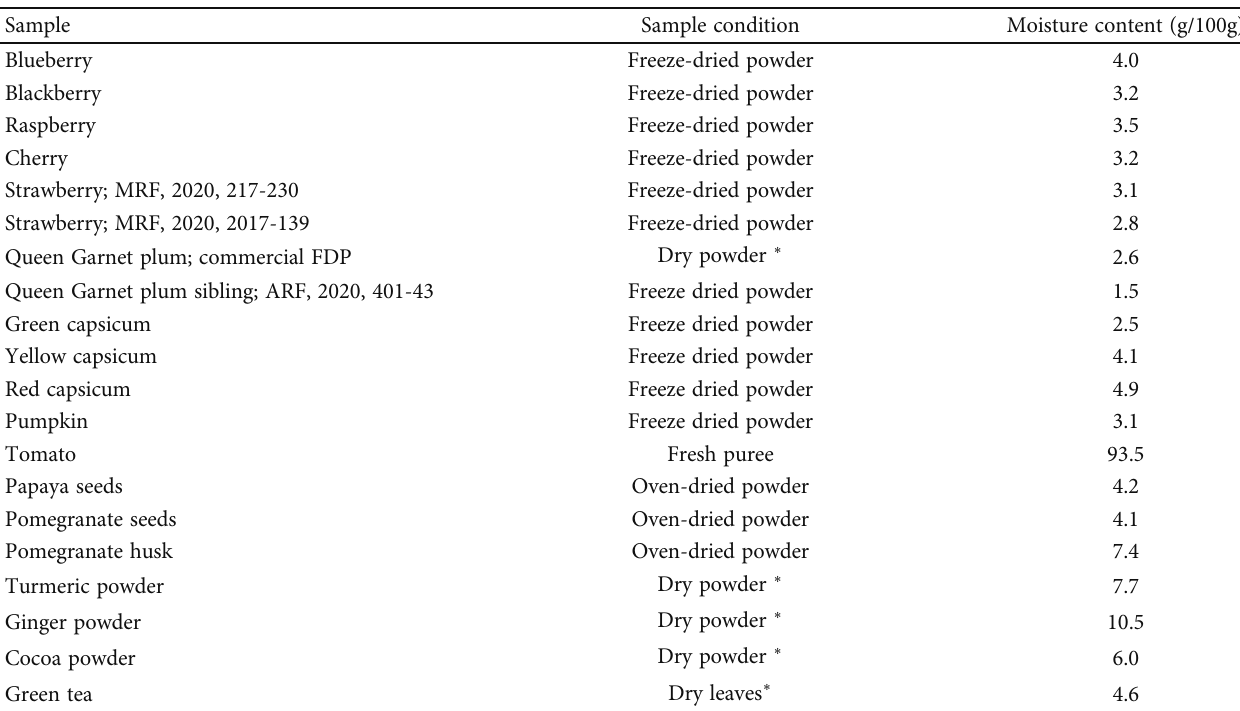
Table 4: Moisture content of the freeze-dried/oven-dried/fresh samples